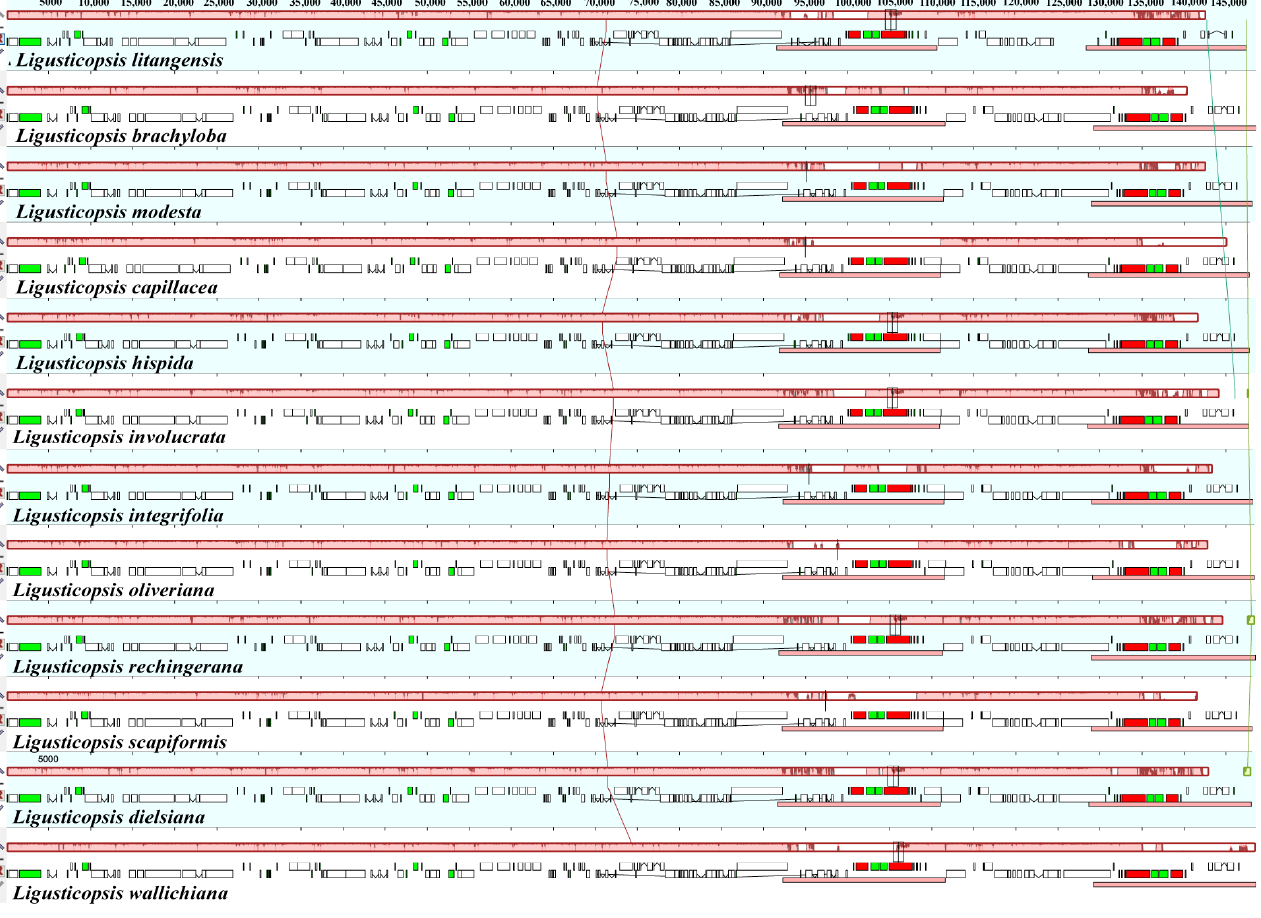
Figure 5. Alignment of the twelve Ligusticopsis plastomes (mauve graphs). Local collinear blocks within each alignment are represented by blocks of the same color connected with lines.